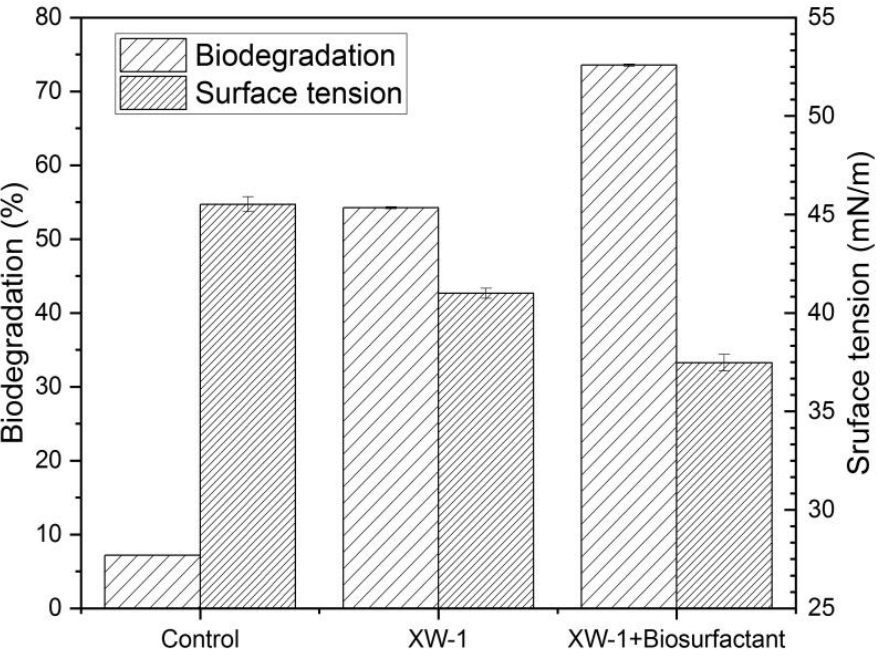
Figure 4. Biodegradation rate of petroleum in water. (1) 25 mL MMC; (2) 25 mL+1% bacteria; (3) 20 mL MMC+ 1% bacteria+ 5 mL biosurfactant solution (60